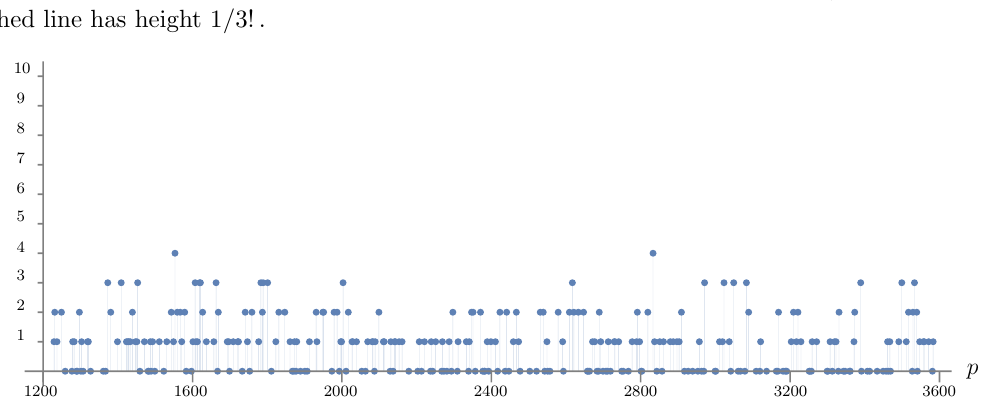
Figure 18 . The residual factorisations for AESZ34 after eliminating the primes up to p 200 = 1223. torisations, the frequency is 2 = 302=0 : 00662 which is about 1 = 6 of 1 = 4!, the lower bound suggested by the Chebotar(cid:127)ev theorem. For degrees of 5 and above we cannot say more without more extensive